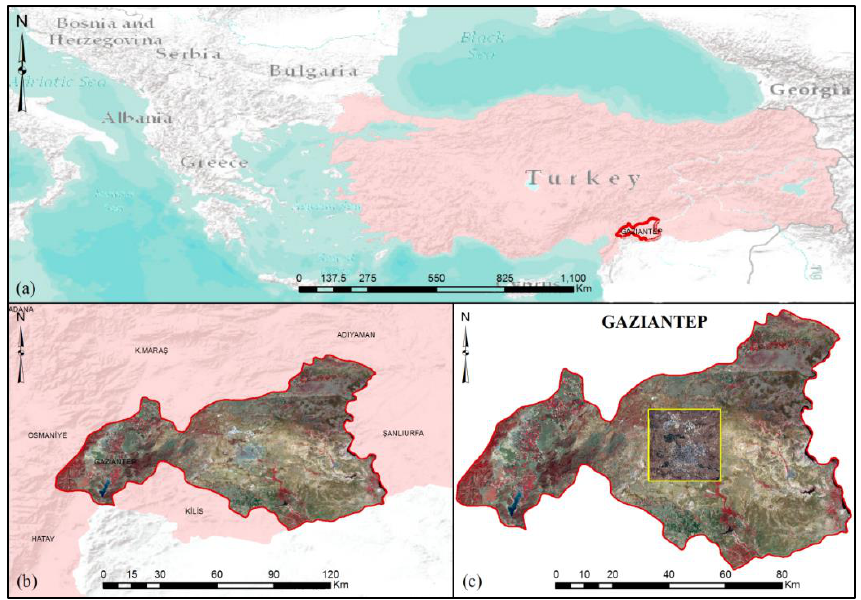
Figure 1. Location of the study area (a) Turkey’s location (b) Gaziantep (c) Location of the study are